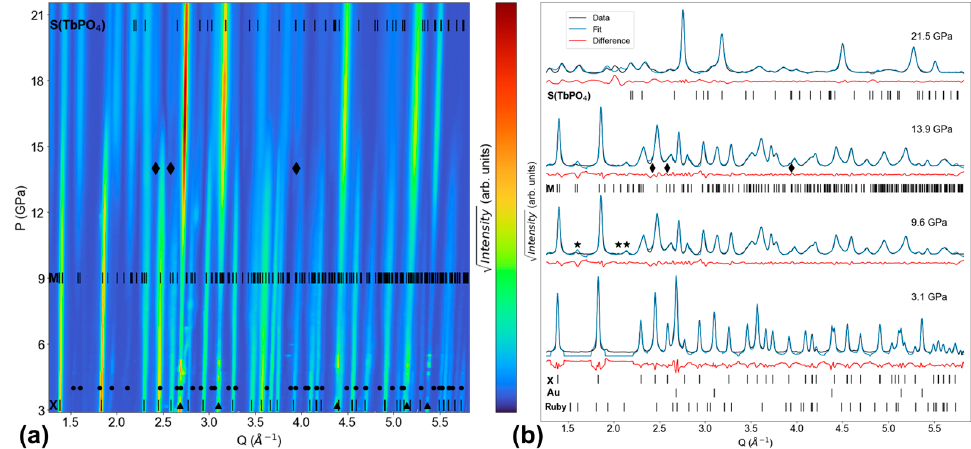
Figure 4. Synchrotron XRD patterns. X, M, and S(TbPO 4 ) ticks show Bragg reflections of xenotime DyPO 4 , monazite DyPO 4 , and scheelite TbPO 4 , the last based on ab initio structural data reported by Lopez-Solano et al. [23]. Star symbols mark emerging monazite peaks at 9.6(7) GPa, and diamond symbols mark emerging peaks of the unidentified phase at 13.9(10) GPa. ( a ) A contour plot showing all XRD patterns. Peak positions of gold and ruby are marked with triangles and circles, respectively. ( b ) The LeBail fits of key patterns (initial scan, onset of monazite, onset of unidentified phase, and final scan).